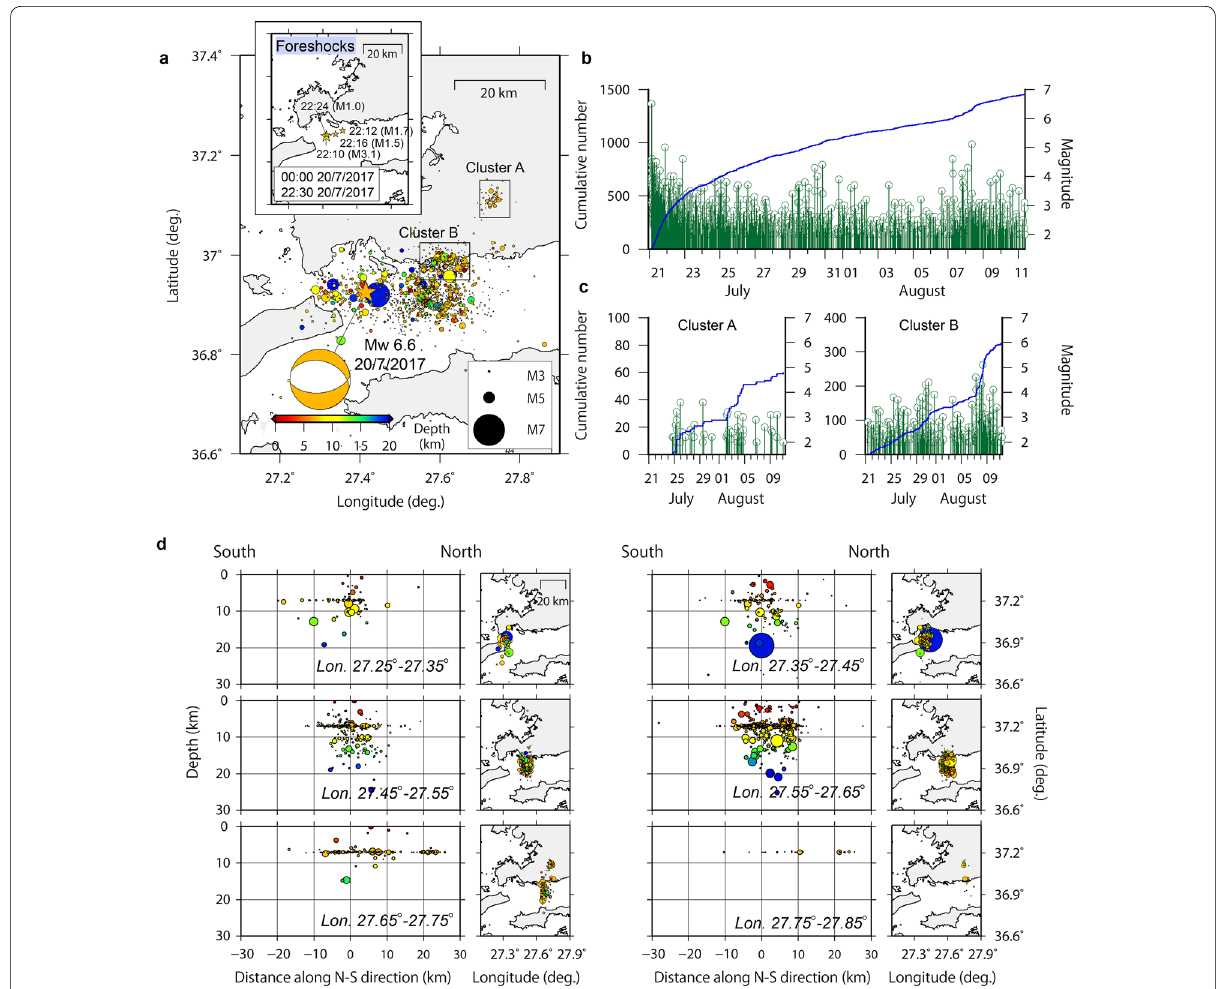
Fig. 2 Aftershock analysis for the 20 July 2017 Bodrum–Kos earthquake in Turkey. a Distribution of aftershocks ( M catalog provided by AFAD (Disaster and Emergency Management Authority, Earthquake Department, Turkey). The color map of the circles shows the hypocentral depth. The inset shows the hypocenter distribution of foreshocks on the day of the 2017 Bodrum–Kos earthquake. b , c Cumulative frequency curve (blue) and magnitude–time diagram (green) for the entire region and for two seismic clusters of A and B, respectively. d Cross sec- tions of aftershock hypocenters at various longitude ranges (left panels) and their epicentral projections (right